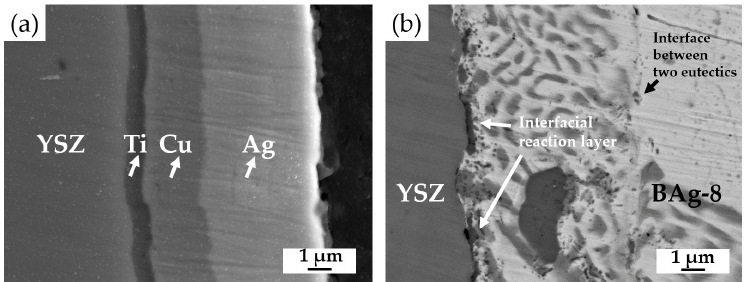
Figure 9. EPMA BEI cross sections: ( a ) Ag(5 μ )/Cu(3 μ )/Ti(1 μ )/YSZ substrate before brazing and ( b ) the YSZ side of BJ-2 after brazing.